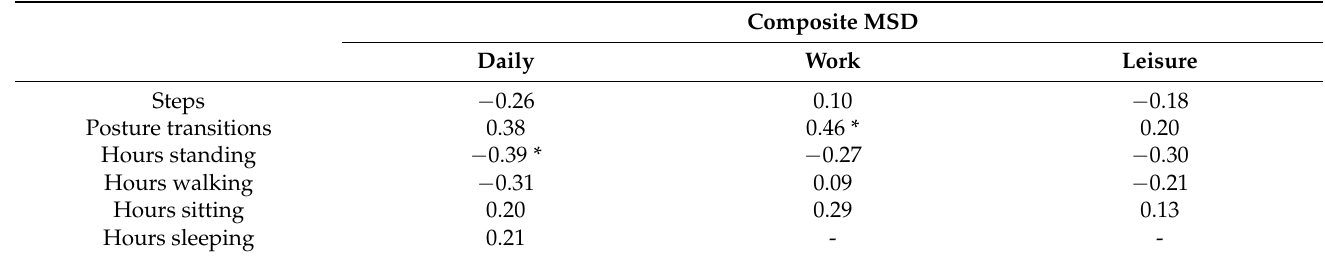
Table 4. Spearman correlations between transitions, step count, and durations spent in various postures for those with composite musculoskeletal discomfort at